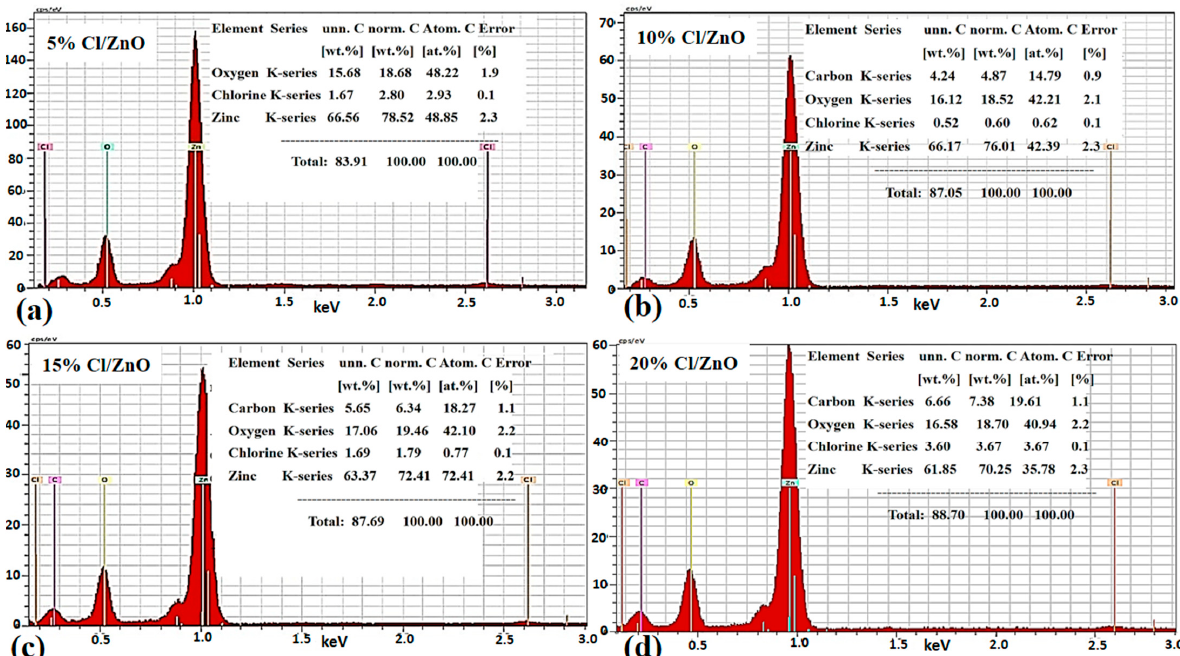
Figure 3. ( a – d ) The elemental composition of 5%, 10%, 15% and 20% Cl − -doped ZnO nanostructures.